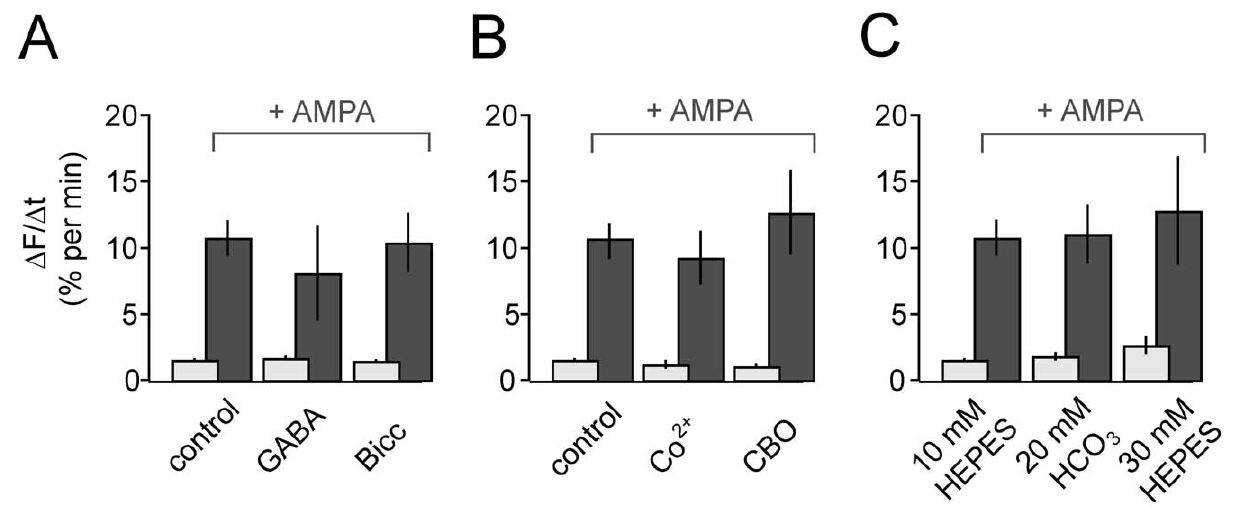
Figure 4. Blockers of hypothesized mechanisms of negative feedback have no effect on AMPA-accelerated release from cone terminals. (A) Tonic release in darkness is unaffected by GABA (500 m M; n =8) or bicuculline (100 m M; n =5) and AMPA-accelerated release is not significantly altered by either GABA ( n =6, p =0.15) or bicuculline ( n =5, p =0.56). (B) Tonic release is slightly reduced by the hemichannel blockers Co 2 + (100 m M; n =8) and carbenoxolone (CBO; 100 m M; n =10), but neither Co 2 + ( n =8) nor CBO ( n =8) blocks AMPA-accelerated release. (C) Tonic release is slightly increased by increasing the pH buffer concentration from 10 to 30 mM HEPES ( n =8) but unaffected by substituting HEPES with the weaker pH buffer HCO 3 (20 mM) ( n =7). However, neither 30 mM HEPES ( n =6) nor HCO 3 ( n =7) blocks AMPA-accelerated